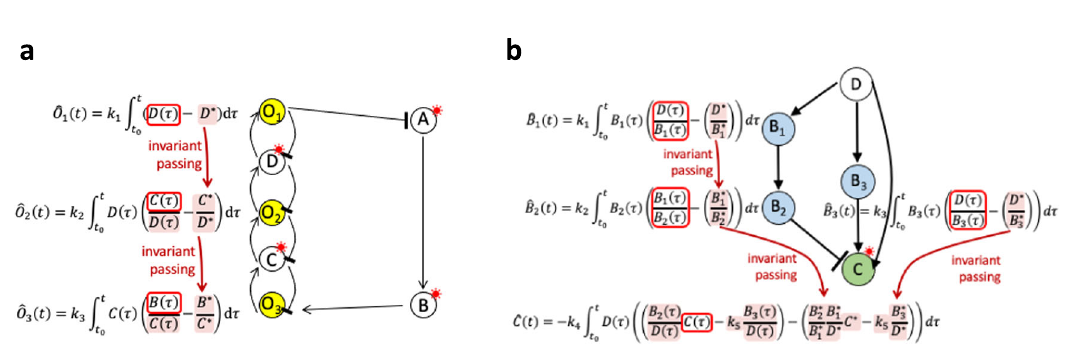
Fig. 7 | The principle of Invariant Passing. Rowspan invariants (obtained via a linear coordinate change applied to the model variables) within a single algebrai- cally independent subnetwork of the CRN, are combined nonlinearly (via a con- catenating monomial, as needed) to produce the RPA polynomial of the subnetwork. a In CRN subnetworks of opposer type, polynomial invariants in the